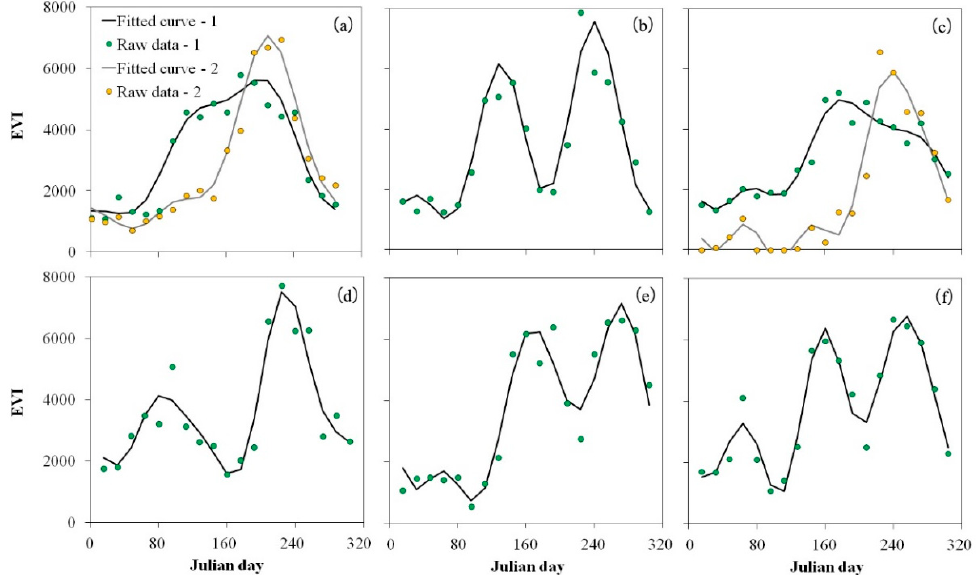
Figure 3. Time series profile curves of the vegetation index in regions where double cropping could potentially be applied, though it is not necessarily applied ( a , b ) and in regions where triple cropping could potentially be applied, though it is not necessarily applied ( c – f ). Curves with green dots are the major patterns considered in this study. The curves with yellow dots in ( a , c ) indicate the presence of a single cropping pattern, but these patterns were not the majority and so were not separated from the majority type presented by green dots. We named these patterns as follows: pattern 2-1 ( a ), pattern 2-2 ( b ), pattern 3-1 ( c ), pattern 3-2 ( d ), pattern 3-3 ( e ), and pattern 3-4 ( f ). Consistent with Zuo et al. (2013), we avoided false peaks by discarding data obtained after 320 Julian day, which was especially helpful when winter wheat was planted.